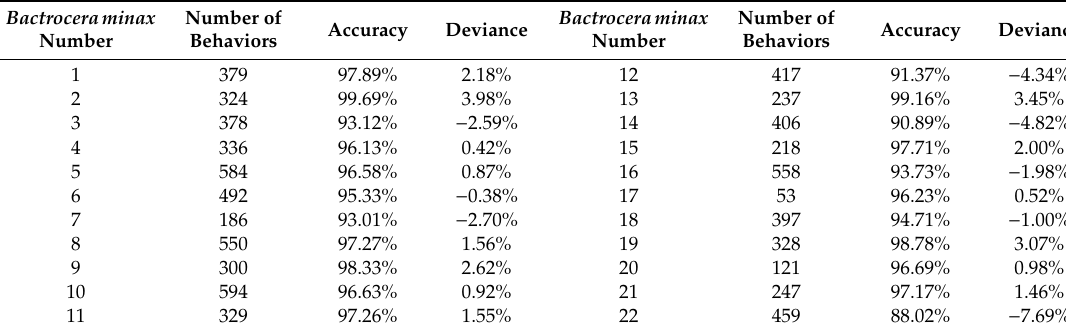
Table 3. Accuracy of behavior detection results.